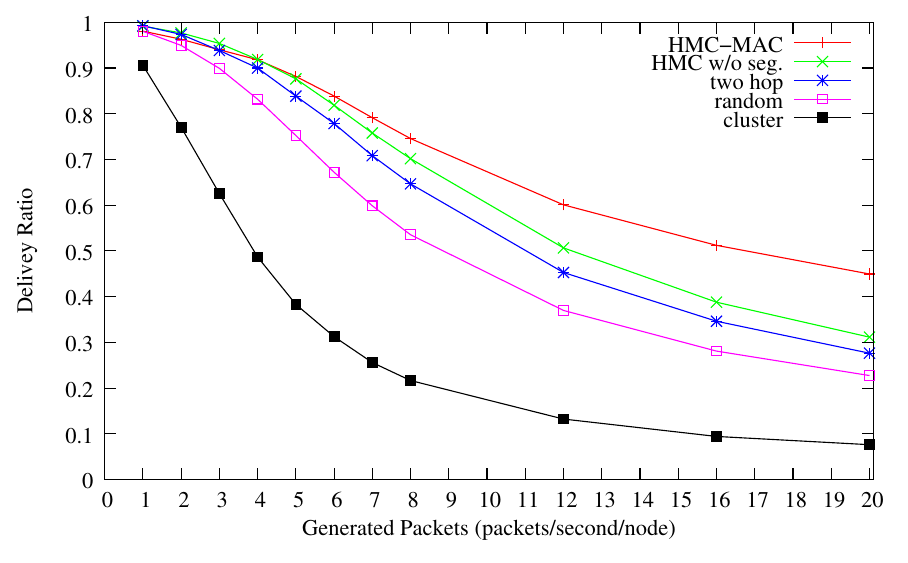
Figure 9. Delivery ratio at the sink for periodic